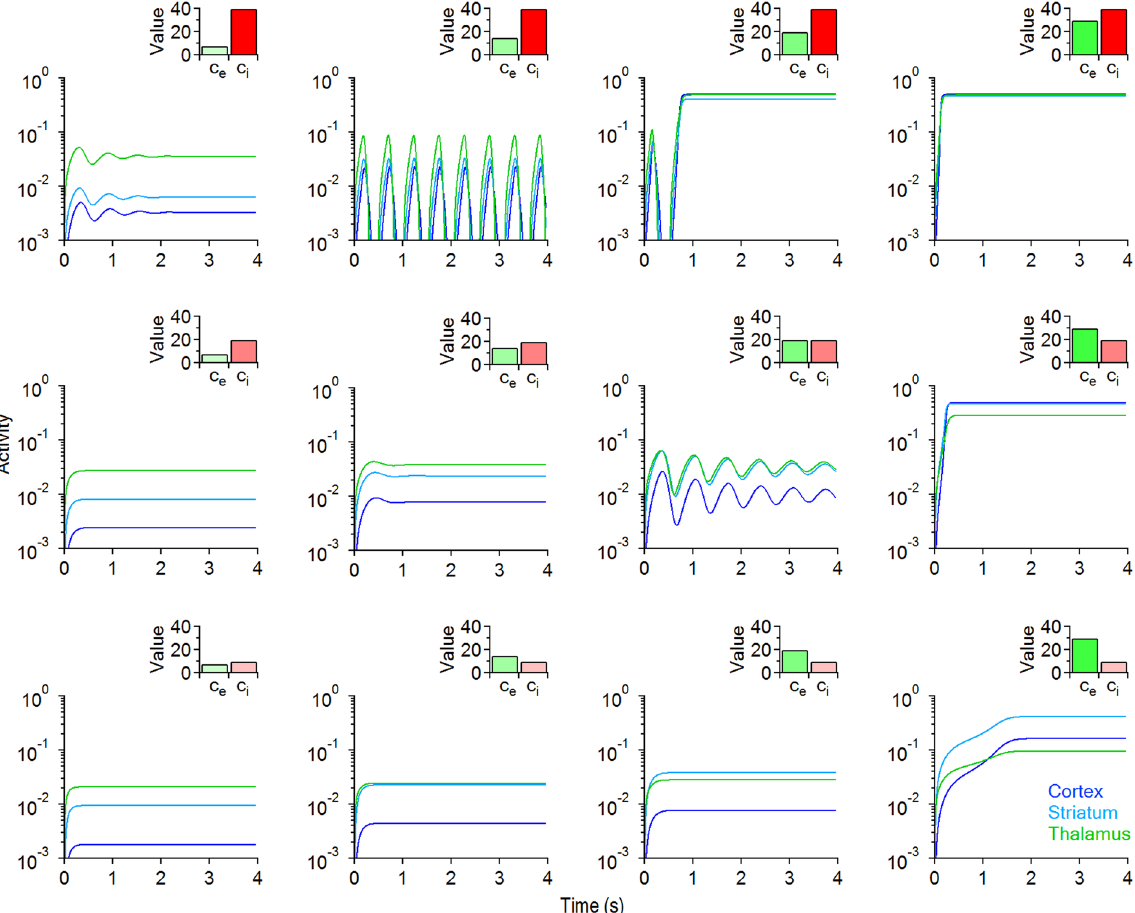
Figure 2. Evolution of the temporal behavior of the CSTC pathway in response to changes in global excitation ( c e ) and inhibition ( c i ). Each curve represents the temporal evolution in the activity of the cortex (blue), striatum (cyan) and thalamus (green). The insets show the values of c e and c i used in each set of simulations ( c e = 8, 15, 20, 30 and c i = 10, 20, 40). Excitation increases from left to right in each row. Inhibition increases from bottom to top in each column. Other parameters are fixed as follows: τ e = 4, b e = 1.2, τ i = 2, b i = 1, P =